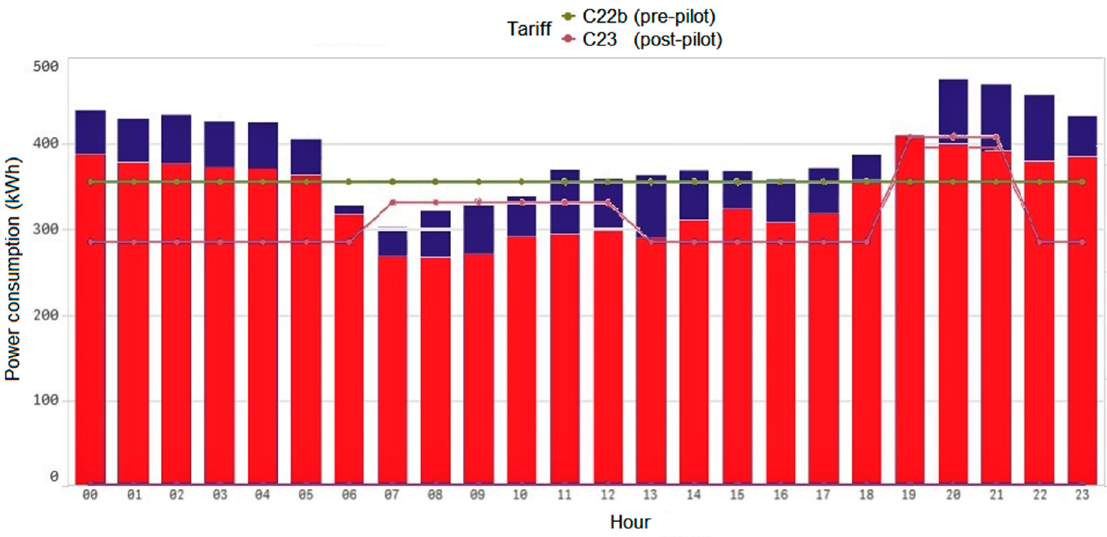
Figure 2. Di ff erences in energy consumption and tari ff adjustment. Figure 2. Differences in energy consumption and tariff adjustment.